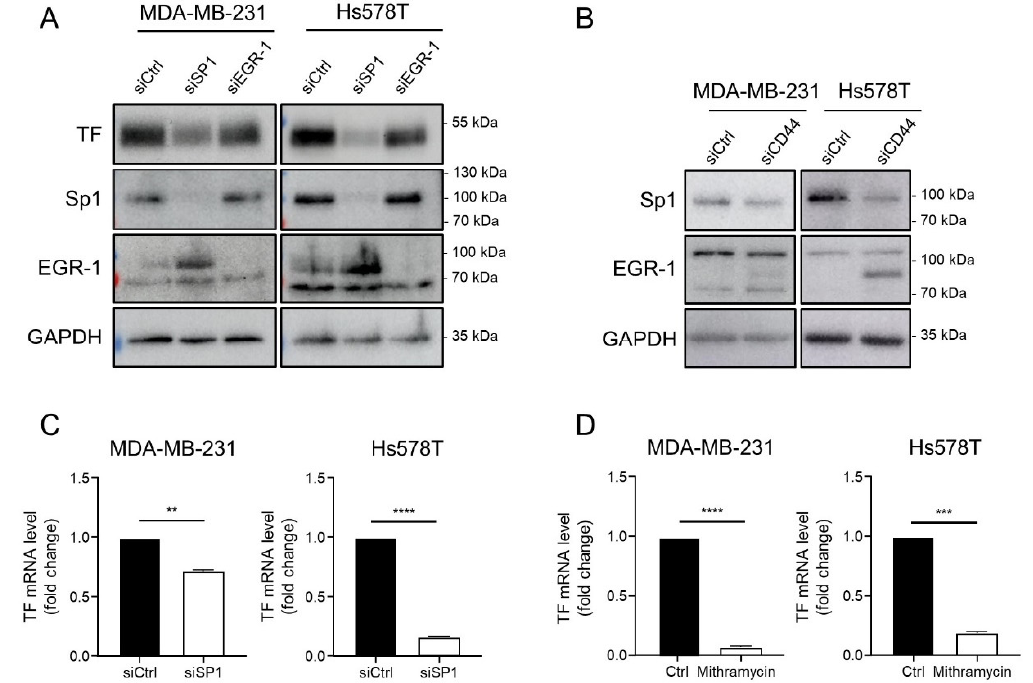
Figure 5. TF is regulated by CD44 at the transcriptional level through an Sp1 dependent mechanism: ( A ) Western blotting analyses of TF, Sp1, EGR-1 and GAPDH in EMT + (MDA-MB-231 and Hs578T) cell lines transfected with a pool of 3 siRNAs directed against Sp1 (siSP1), EGR-1 (siEGR-1) or 3 non-targeting siRNAs (siCtrl) (original western blot images are shown in Supplementary Materials). ( B ) Western blotting analyses of Sp1, EGR-1 and GAPDH in EMT + (MDA-MB-231 and Hs578T) cell lines transfected with a pool of 3 siRNAs directed against CD44 (siCD44) or 3 non-targeting siRNAs (siCtrl) (original western blot images are shown in Supplementary Materials). ( C ) RT-qPCR analyses of TF in EMT + (MDA-MB-231 and Hs578T) cell lines transfected with a pool of 3 siRNAs directed against Sp1 (siSP1) or 3 non-targeting siRNAs (siCtrl). ( D ) RT-qPCR analyses of TF in EMT + (MDA-MB-231 and Hs578T) cell lines treated or not (Ctrl) with mithramycin. **, p < 0.01; ***, p < 0.001; ****, p < 0.0001. (Figure S3: Uncropped Western blot figures)